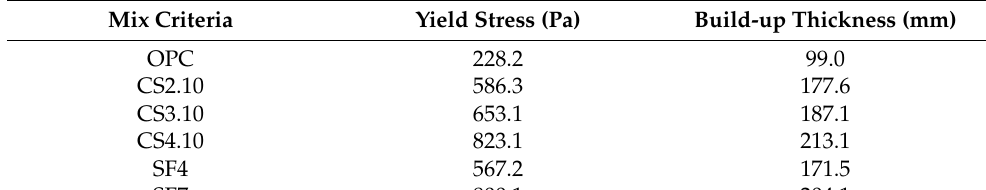
Table 5. Build-up thickness based on yield stress.